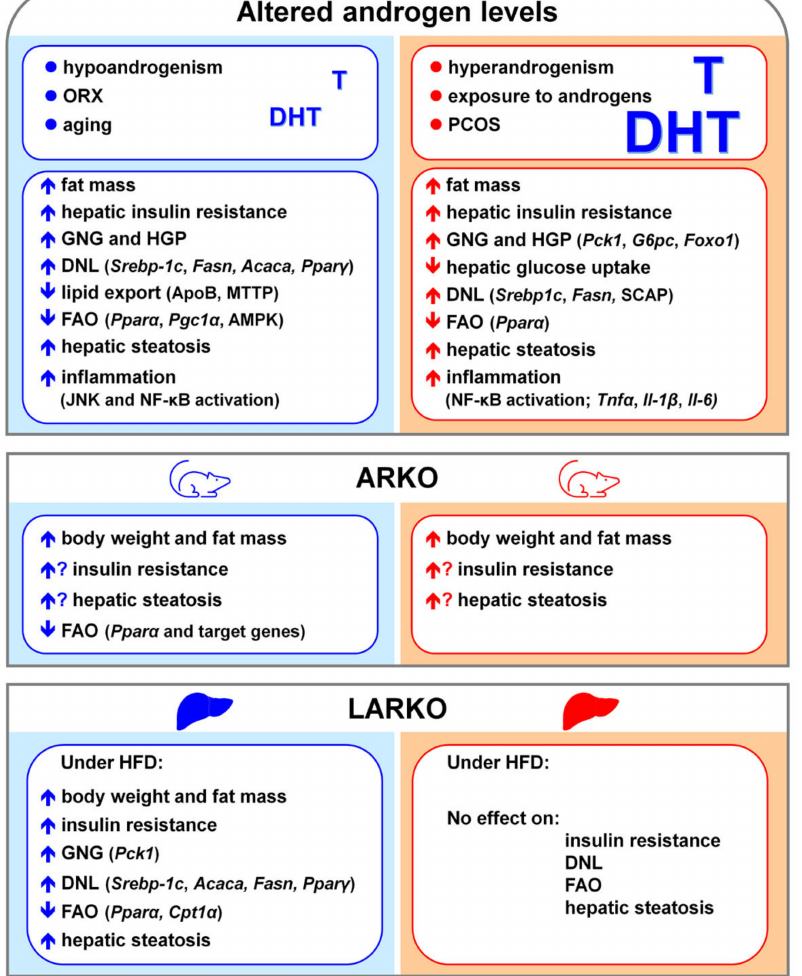
Figure 6. Consequences of altered androgen signaling in the liver of males (left, in blue) and females (right, in red) favoring NAFLD development and progression. Low and high androgen levels are detrimental for the hepatic health of males and females, respectively. Abbreviations: Acaca , acetyl- CoA carboxylase α ; AMPK, AMP-activated protein kinase; ApoB; apolipoprotein B; ARKO, total AR knockout mice; Cpt1 α , carnitine palmitotyltransferase 1; DHT, dihydrotestosterone; DNL, de novo lipogenesis; FAO, fatty acid oxidation; Fasn , fatty acid synthase; Foxo1 , forkhead transcription factor 1; G6pc , glucose-6-phosphatase; GNG, gluconeogenesis; HGP, hepatic glucose production; Il-1 β , interleukin 1 β ; Il-6 , interleukin 6; JNK, c-Jun N-terminal kinase; LARKO, liver AR knockout mice; MTTP; microsomal triglyceride transfer protein; NF- κ B, nuclear factor- κ B; ORX, orchidectomy; Pck1 , phosphoenolpyruvate carboxykinase 1; PCOS, poly-cystic ovary syndrome; Pgc1 α , peroxisome proliferator-activated receptor- γ coactivator-1 α ; Ppar α , peroxisome proliferator activated receptor α ; Ppar γ , peroxisome proliferator activated receptor γ ; Scap , sterol regulatory element-binding protein cleavage-activating protein; Srebp1c , sterol regulatory element binding Transcription factor 1; T, testosterone; Tnf α , tumor necrosis factor α